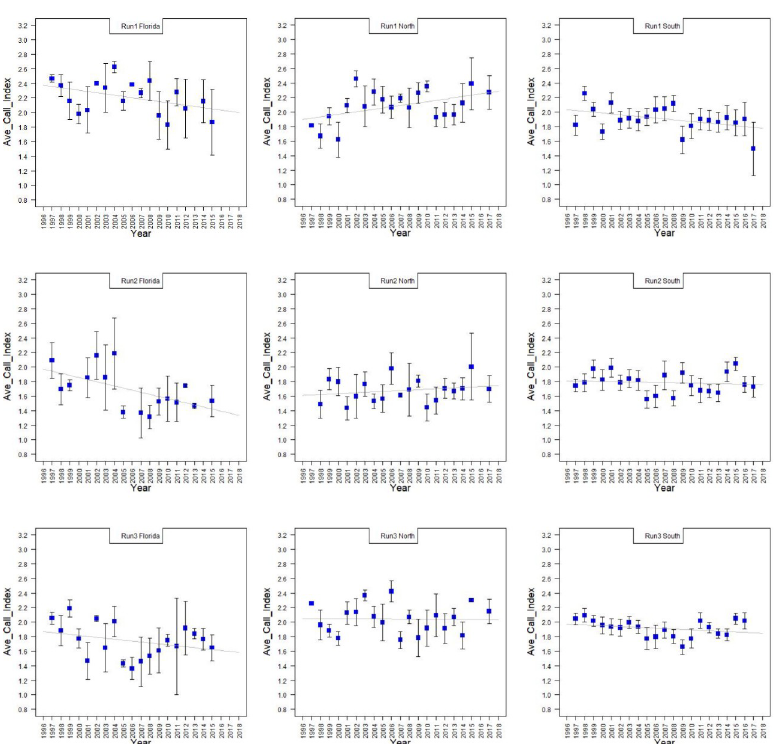
Fig 6. Average call index by region, run and year. The average call index (ACI) is the average of all calls documented on a given route during a given run. Top to bottom the runs are 1, 2, and 3. Right to left the columns are Florida, North, and South regions. The Y-axis is the ACI for a given year. The dots are the average of the ACI for all routes in a region in a given year with standard deviation bars. A linear regression was performed on the data. The regression models are presented in Table 7. Only Florida-Run 2 had a significant